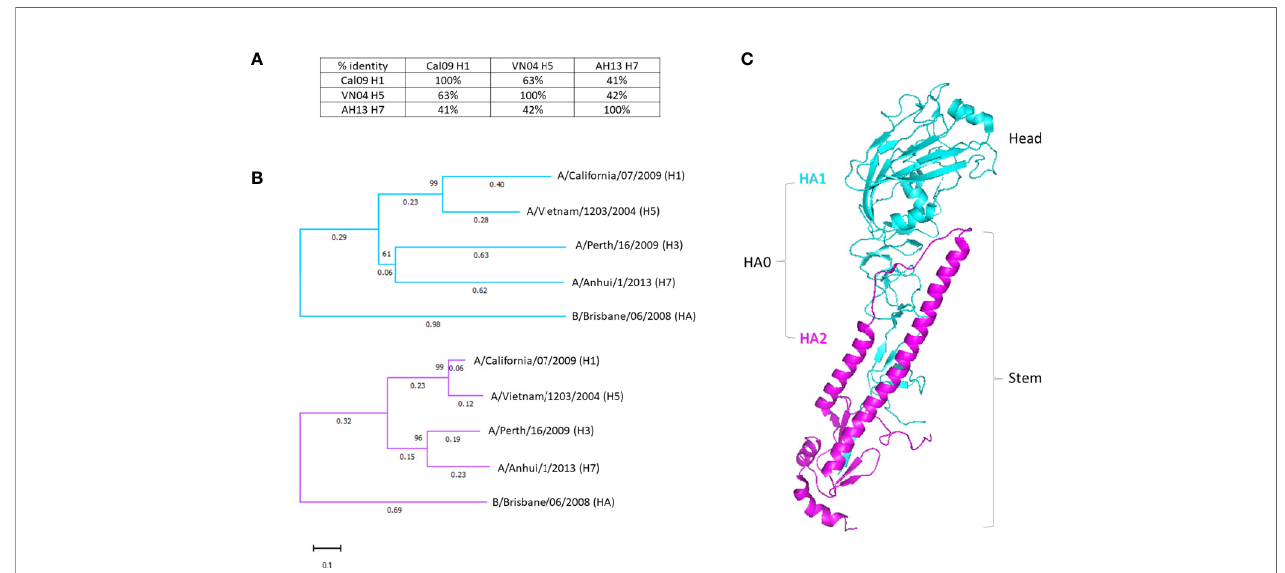
FIGURE 1 | Hemagglutinins used in this study. (A) Percentages of amino acid identities of the three HA variants used for immunization: H1 from A/California/07/2009 (Cal09), H5 from A/Vietnam/1203/2004 (VN04), and H7 from A/Anhui/1/2013 (AH13). Percentages refer to the full-length (HA0) protein. (B) Dendrogram of separate HA1 and HA2 sequences of HA subtypes. HA from an additional Group 2 virus (H3, from A/Perth/16/2009) and a representative in fl uenza B virus are included for context. HA1 sequences shown in cyan, HA2 sequences in magenta. (C) 3-dimensional representation of the HA monomer with HA1 and HA2 sequences colored as in (B) (PDB: